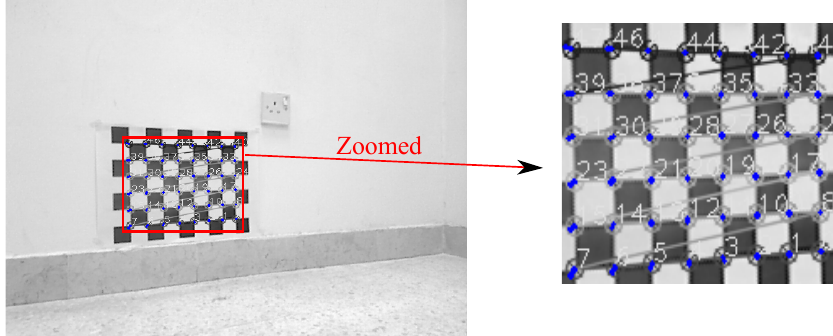
Figure 12. Configuration 4: Reprojection error based on the estimated X and Z matrices. Blue lines indicate the amount of the reprojection error (original image resolution 640 × 480).